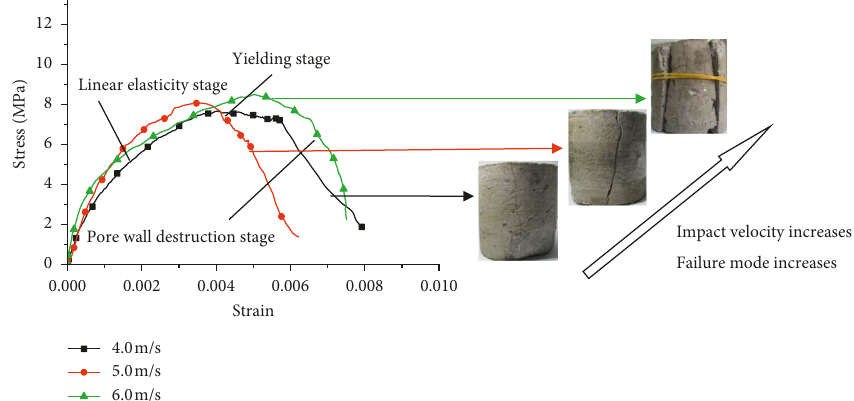
Figure 8: Foam concrete with sand stress-strain curve at 1,000kg/m 3 .